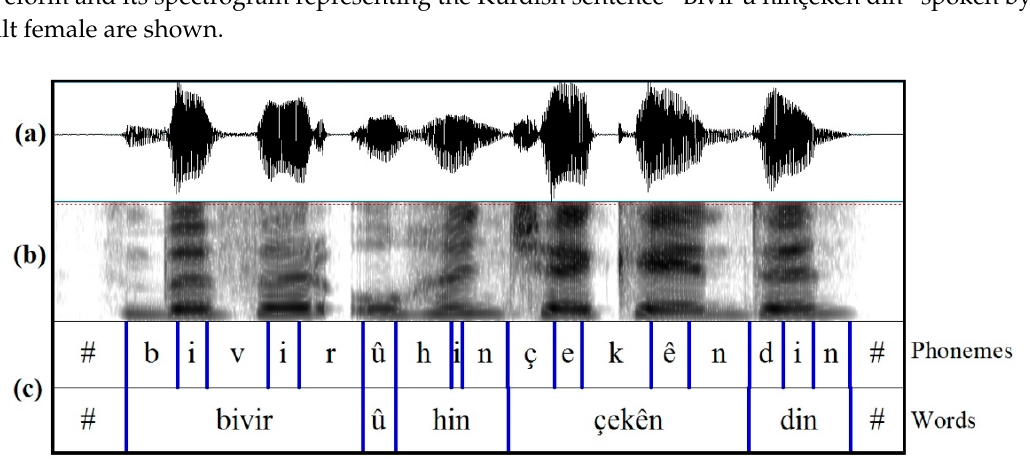
Figure 3. Speech waveform ( a ); spectrogram ( b ) and phonemes and words segmentation ( c ) of the Kurdish sentence.